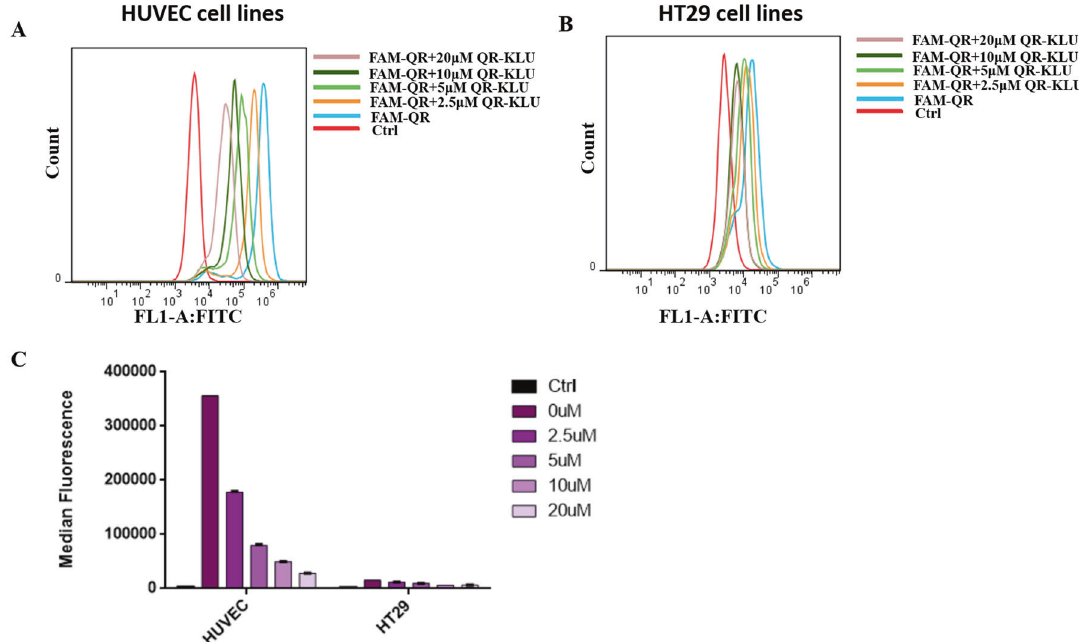
Fig. 2 The cell af fi nity of QR-KLU with different cell lines. Cell penetration of peptide QR-KLU with HUVEC cells ( A ) and HT29 cells ( B ). The cells were respectively treated with PBS, 10 μ M FAM-QR + 0 μ M QR-KLU, 10 μ M FAM-QR + 2.5 μ M QR-KLU, 10 μ M FAM-QR + 5 μ M